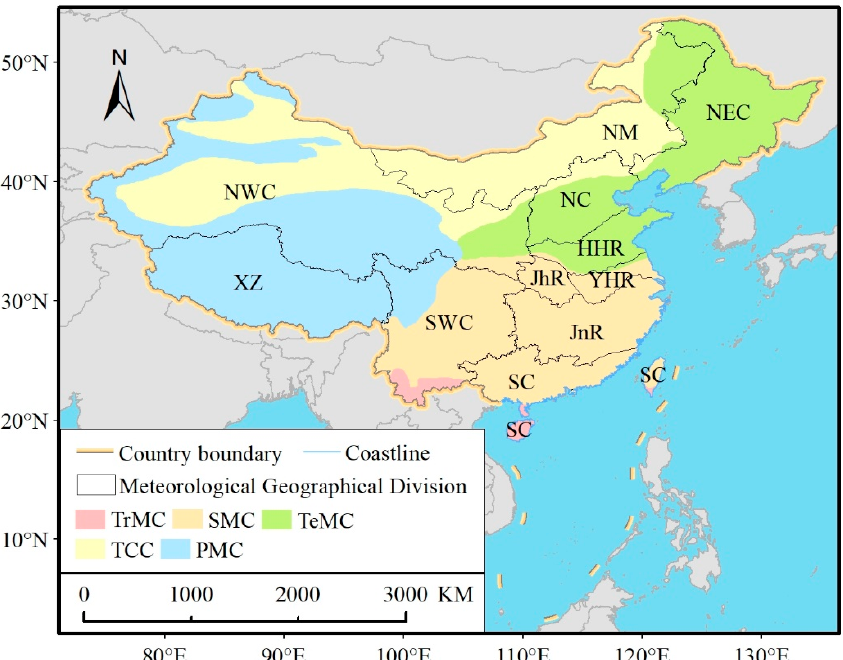
Figure 1. Map showing the location of China, climate types in China (TrMC: Tropical Monsoon Climate; SMC: Subtropical Monsoon Climate; TeMC: Temperate Monsoon Climate; TCC: Temperate Continental Climate; PMC: Plateau Mountain Climate), and Meteorological Geographical Division in China (NEC: Northeast China; NC: North China; HHR: Huang-Huai Region; JhR: Jianghan Region; YHR: Yangtze-Huaihe Region; JnR: Jiangnan Region; SC: South China; SWC: Southwest China; NWC: Northwest China; NM: Inner Mongolia; XZ: Tibet).